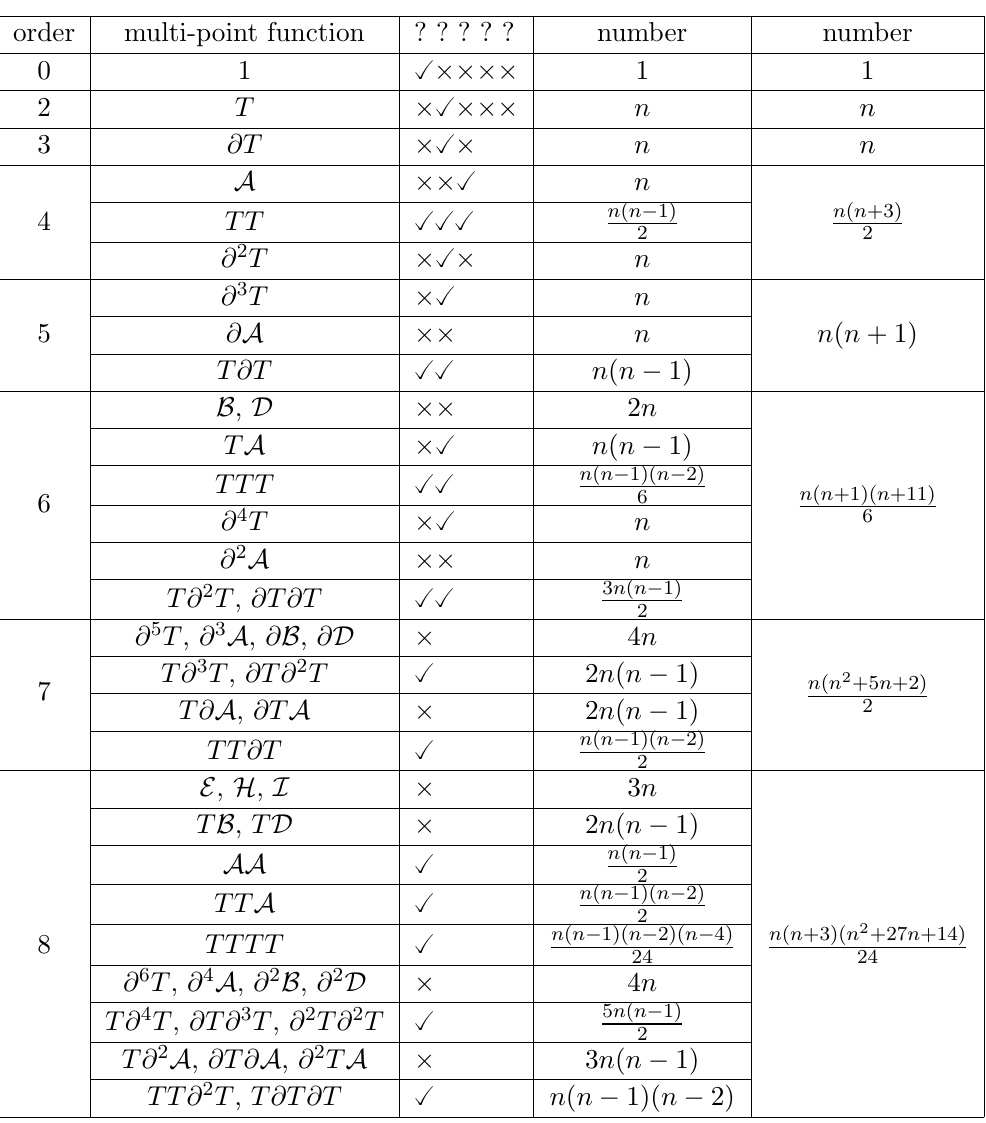
Table 1 . All the multi-point functions we have to consider in obtaining the excited state R(cid:19)enyi entropy up to order ( ‘=L ) 8 . In the 1st column it is the order from which each multi-point function starts to contribute. In the 2nd column listed are the multi-point functions, and for simplicity we have omitted the correlation function symbol h(cid:1) (cid:1) (cid:1)i C and the positions of the operators, which should be e 2 (cid:25) i j 1 =n ; e 2 (cid:25) i j 2 =n ; (cid:1) (cid:1) (cid:1) . The j ’s take values from 0 ; 1 ; (cid:1) (cid:1) (cid:1) ; n (cid:0) 1 with constraints